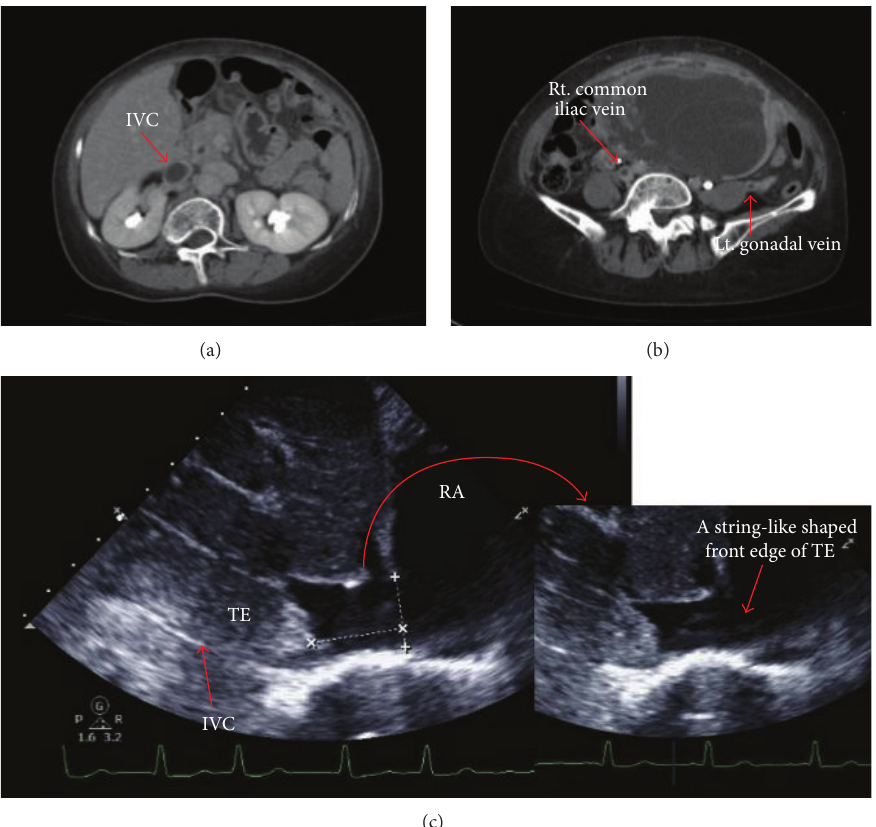
Figure 2: (a, b) Axial computed tomography revealed tumor emboli extending from the uterus to the inferior vena cava. (b) Right common iliac and left gonadal veins. (c) Cardiac ultrasonography revealed a string-like front edge of the tumor embolism inside the right atrium. IVC, inferior vena cava; TE, tumor embolism; RA, right atrium.